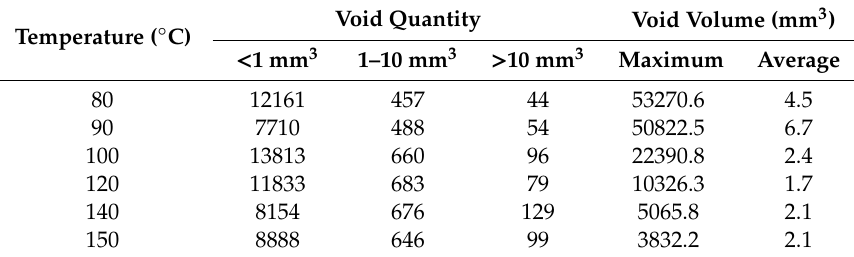
Table 9. Quantity and volume of voids in asphalt mixtures.